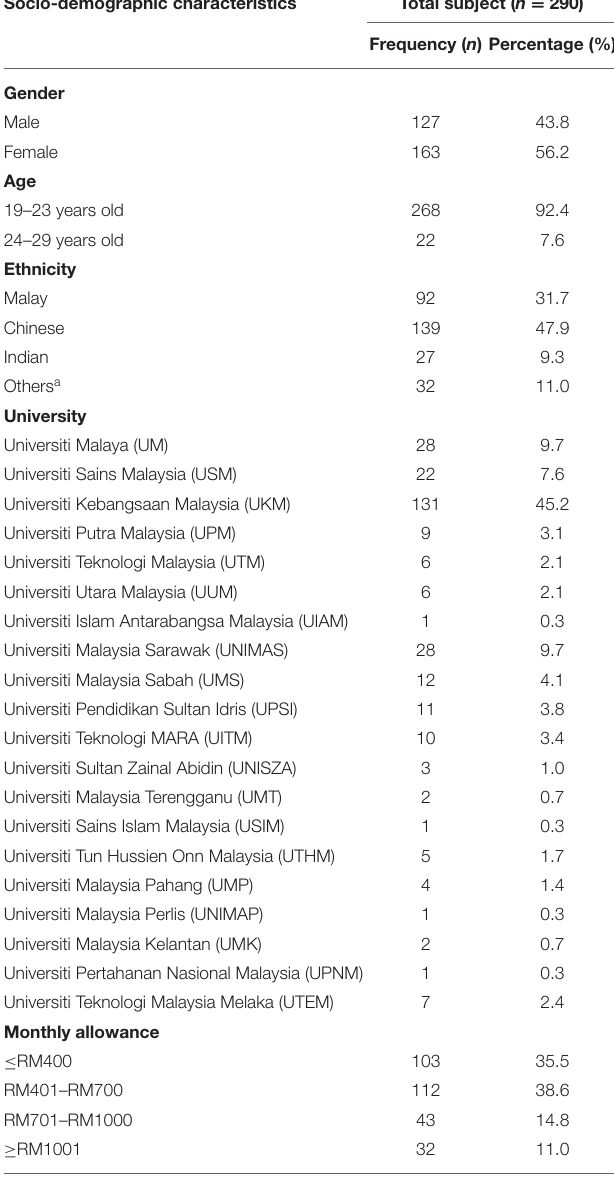
TABLE 2 | Socio-demographic Characteristics of